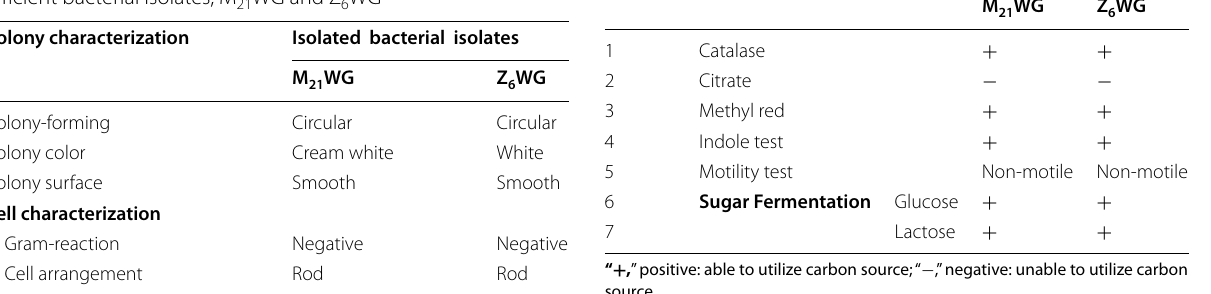
WG and Z WG 21 6